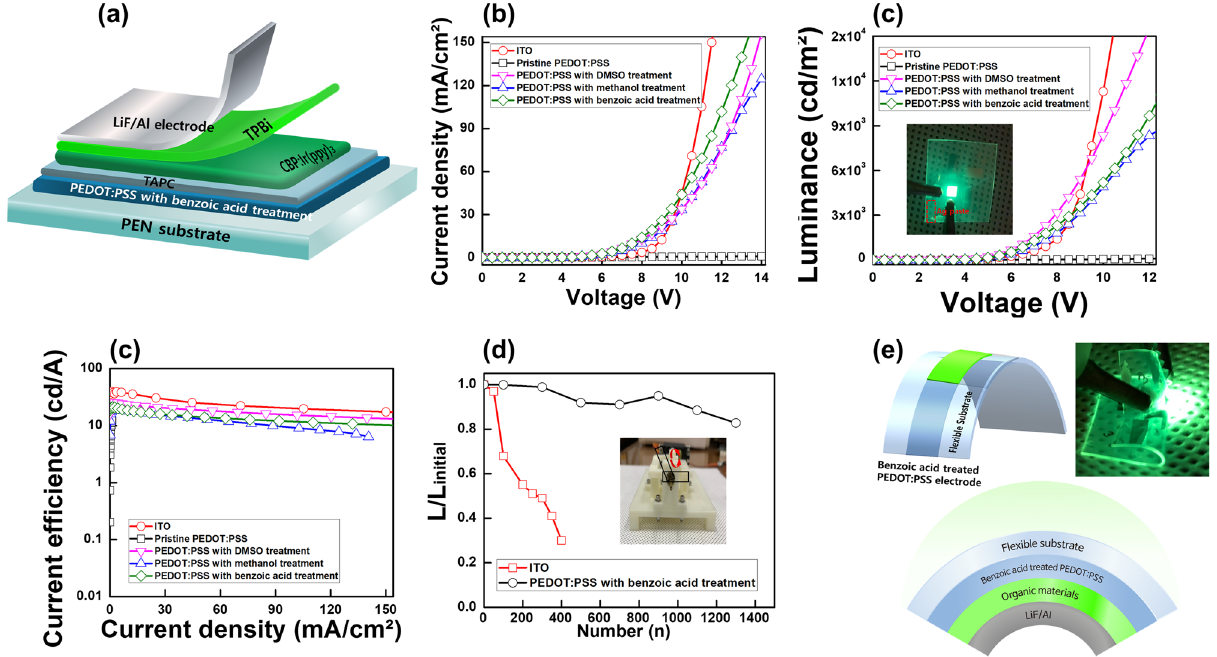
Figure 6. ( a ) Schematic diagram, ( b ) current density – voltage, ( c ) luminance – voltage, ( d ) current efficiency – current density, ( e ) bending stability of flexible OLEDs, ( f ) schematic illustrations of bending test and photographic images of flexible OLED using the PEDOT:PSS electrode with benzoic acid treatment (Kang et